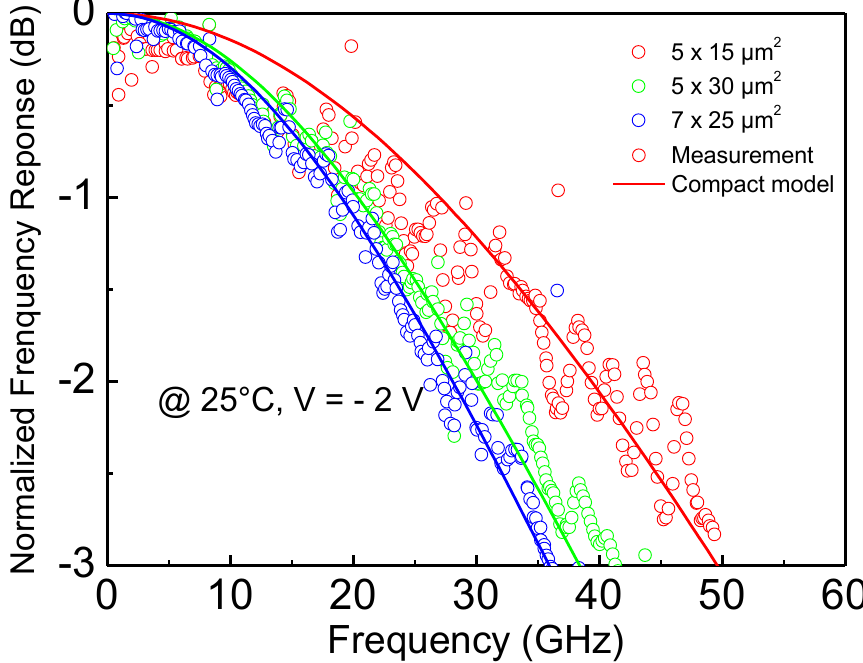
Figure 19. Measured (symbol) and simulated (line) normalized frequency response of UTC-PD with geometries of 5 × 15 µ m 2 (red symbol), 5 × 30 µ m 2 (green symbol) and 7 × 25 µ m 2 (blue symbol).